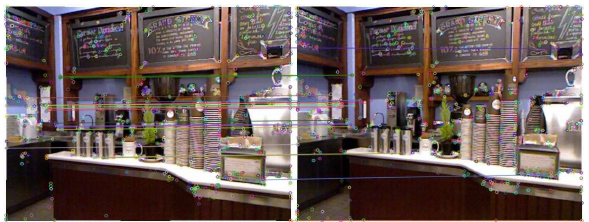
Figure 4. Extract feature points in whole image and good matches condition is 5 times the minimum distance